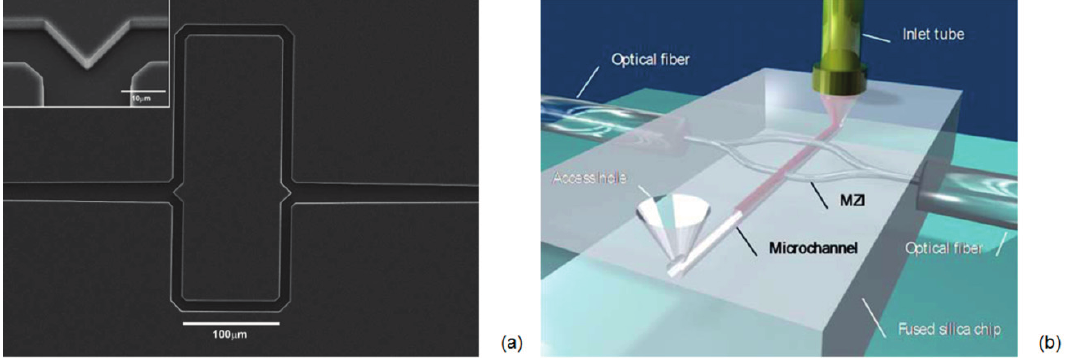
Figure 4. ( a ) SEM image of the second generation LC-MZI. Reprinted with permission from [65] (Copyright (2010) OSA) ( b ) Schematic of the femtosecond-laser-fabricated microfluidic channel and integrated MZI. Reprinted with permission from [66] (Copyright (2010) RSC